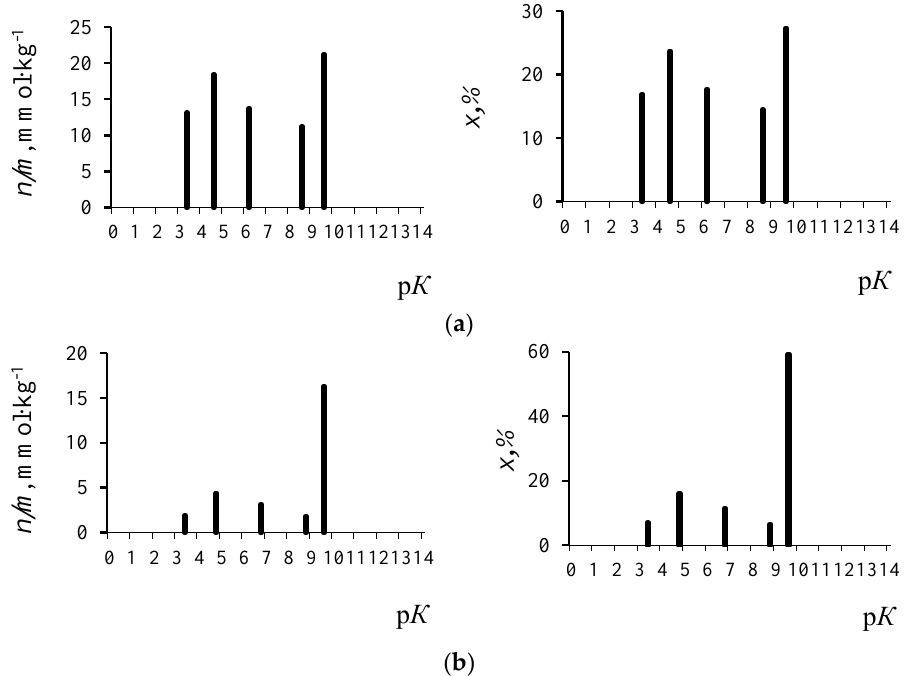
Figure 4. p K spectra of water extracts ( a ) and scour waters ( b ) of the O horizon of Distric Albic Retisol (Loamic): n / m – the number of acid groups (mmol∙kg −1 ), x – the molar fraction (%).